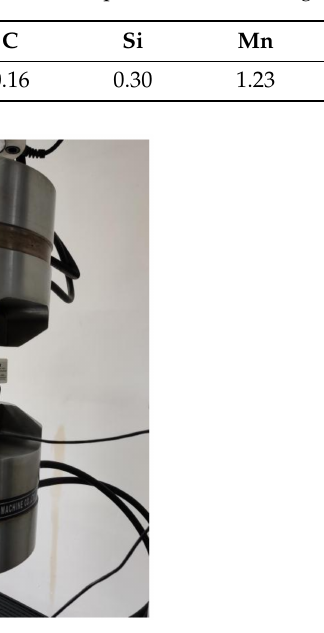
Table 1. Main chemical composition (wt%) of high-strength steel Q345.